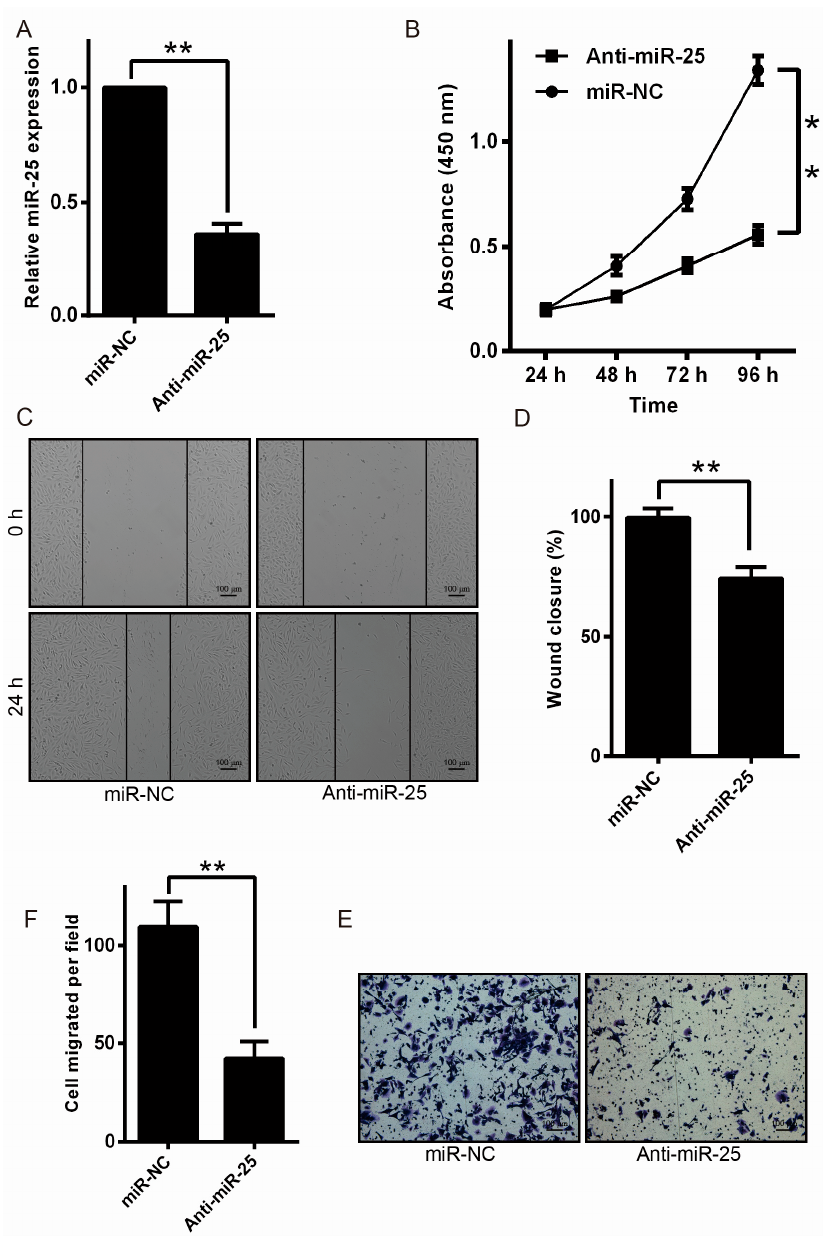
Figure 2. miR-25 downregulation inhibits melanoma cell motility and proliferation. ( A ) Anti-miR-25, or miR-NC, was transfected into MV3 cells and the levels of miR-25 were measured by qRT-PCR; ( B ) MV3 cells proliferation was evaluated using the MTT (Methyl Thiazolyl Tetrazolium); ( C , D ) MV3 cells was determined by wound-healing assays to detect the cell motility; ( E , F ) cell migration was detected using the transwell migration method. Data are expressed as the mean ± SD of three independent experiments. * p < 0.05, ** p < 0.01. Scale bar = 100 μ m.